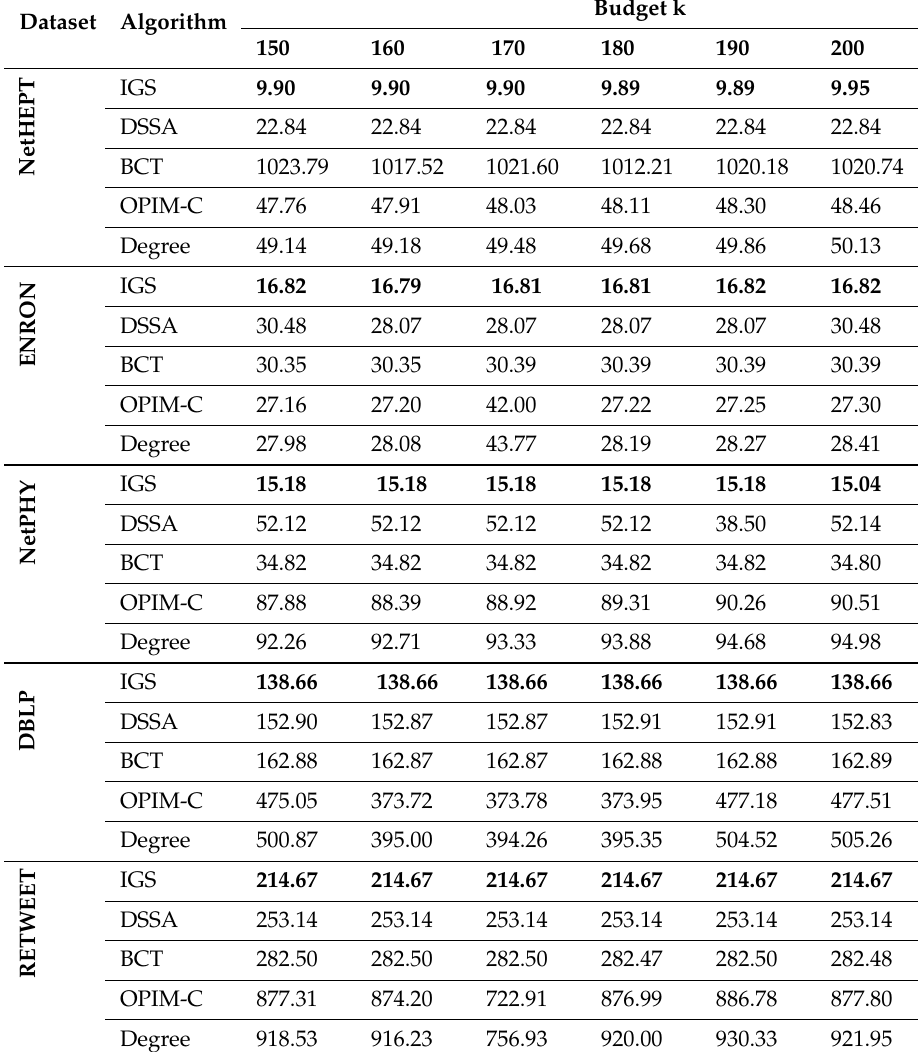
Table 3. Memory usage (MB) comparisons between IGS and the others Dataset